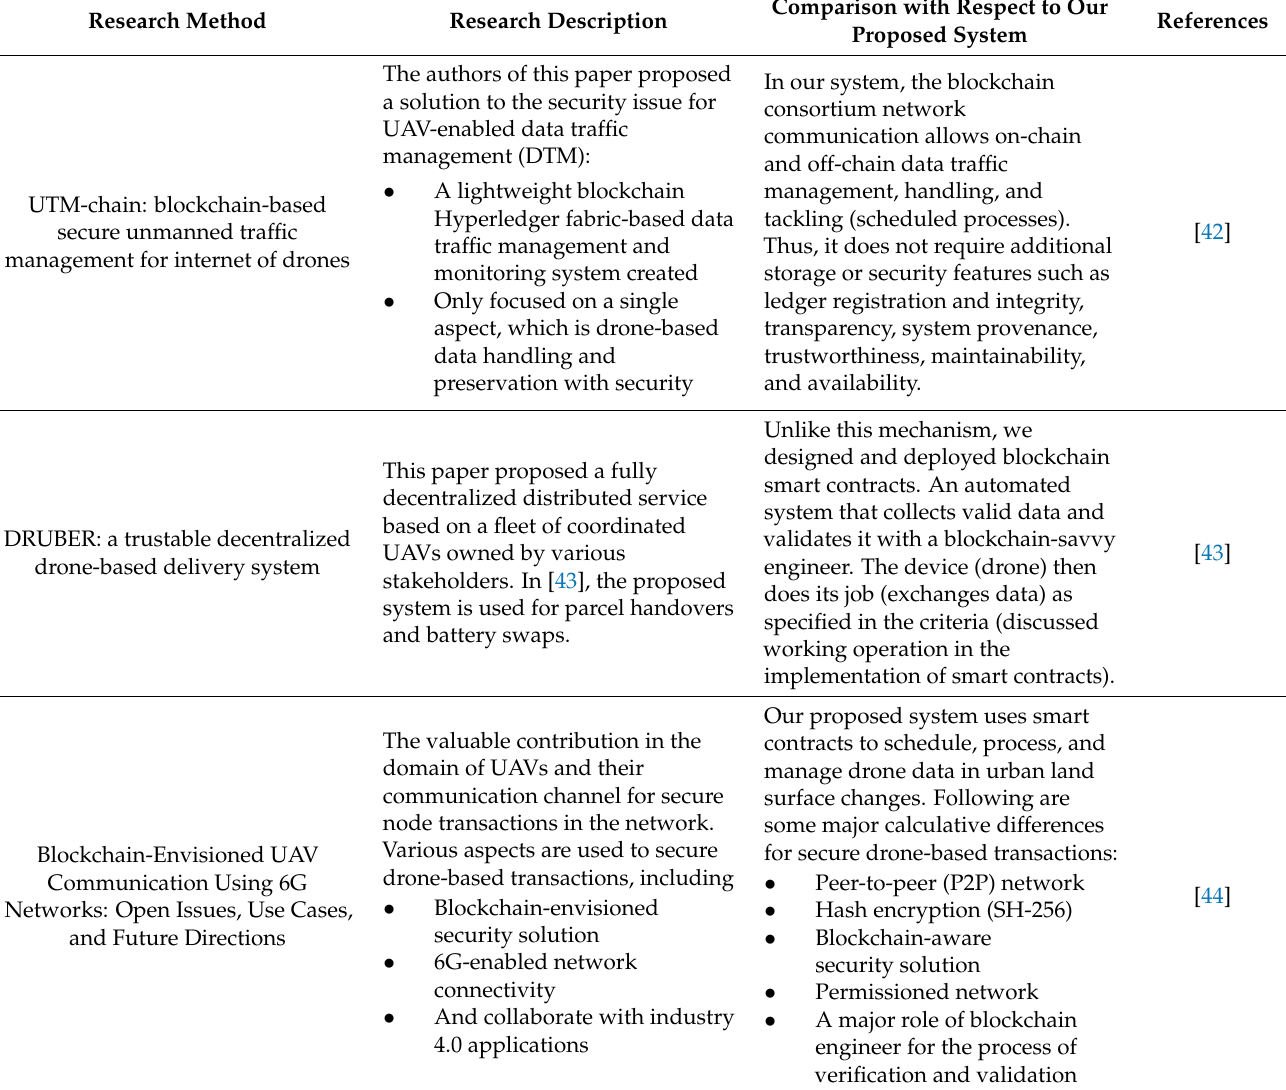
Table 2. Comparison with State-of-the-Art